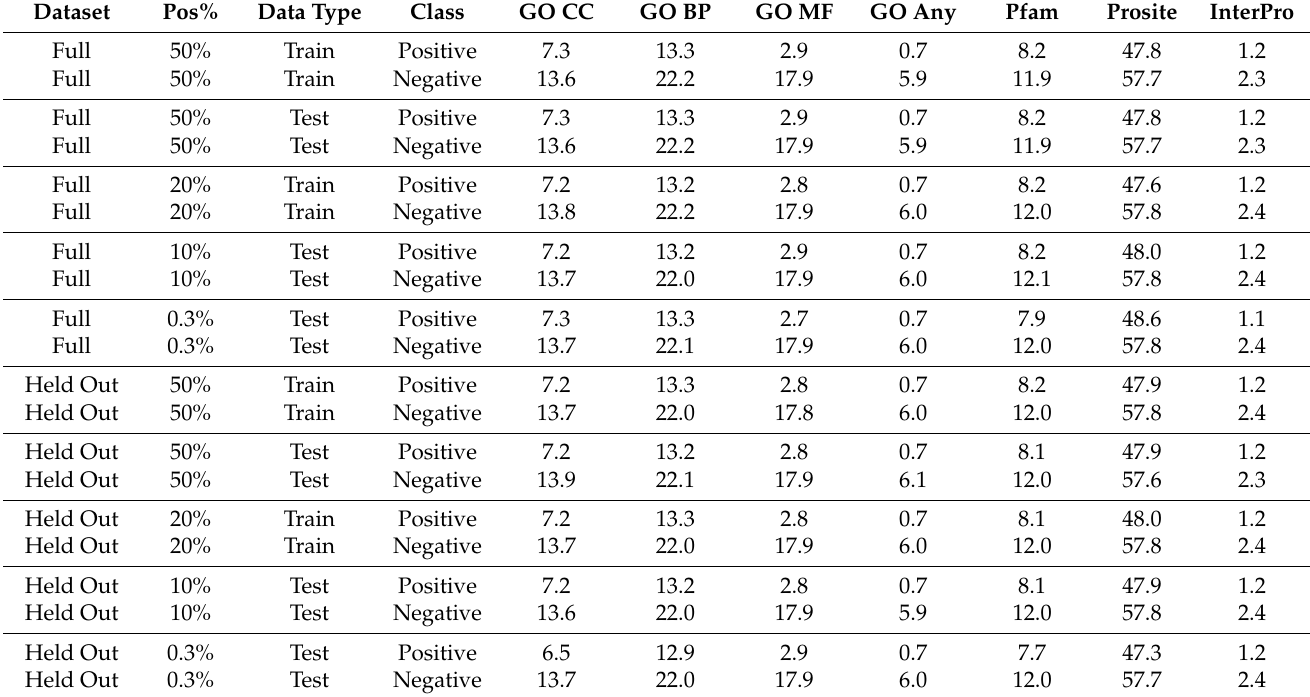
Table 7. Percentages of missing data in the positive and negative our benchmark datasets. Overall, 1–15% more negative data is missing from most datasets in each category. However, most pairs appear to have at least some data, as shown by the GO Any and InterPro columns, each showing at least 94–97% of all protein pairs have some data from GO and